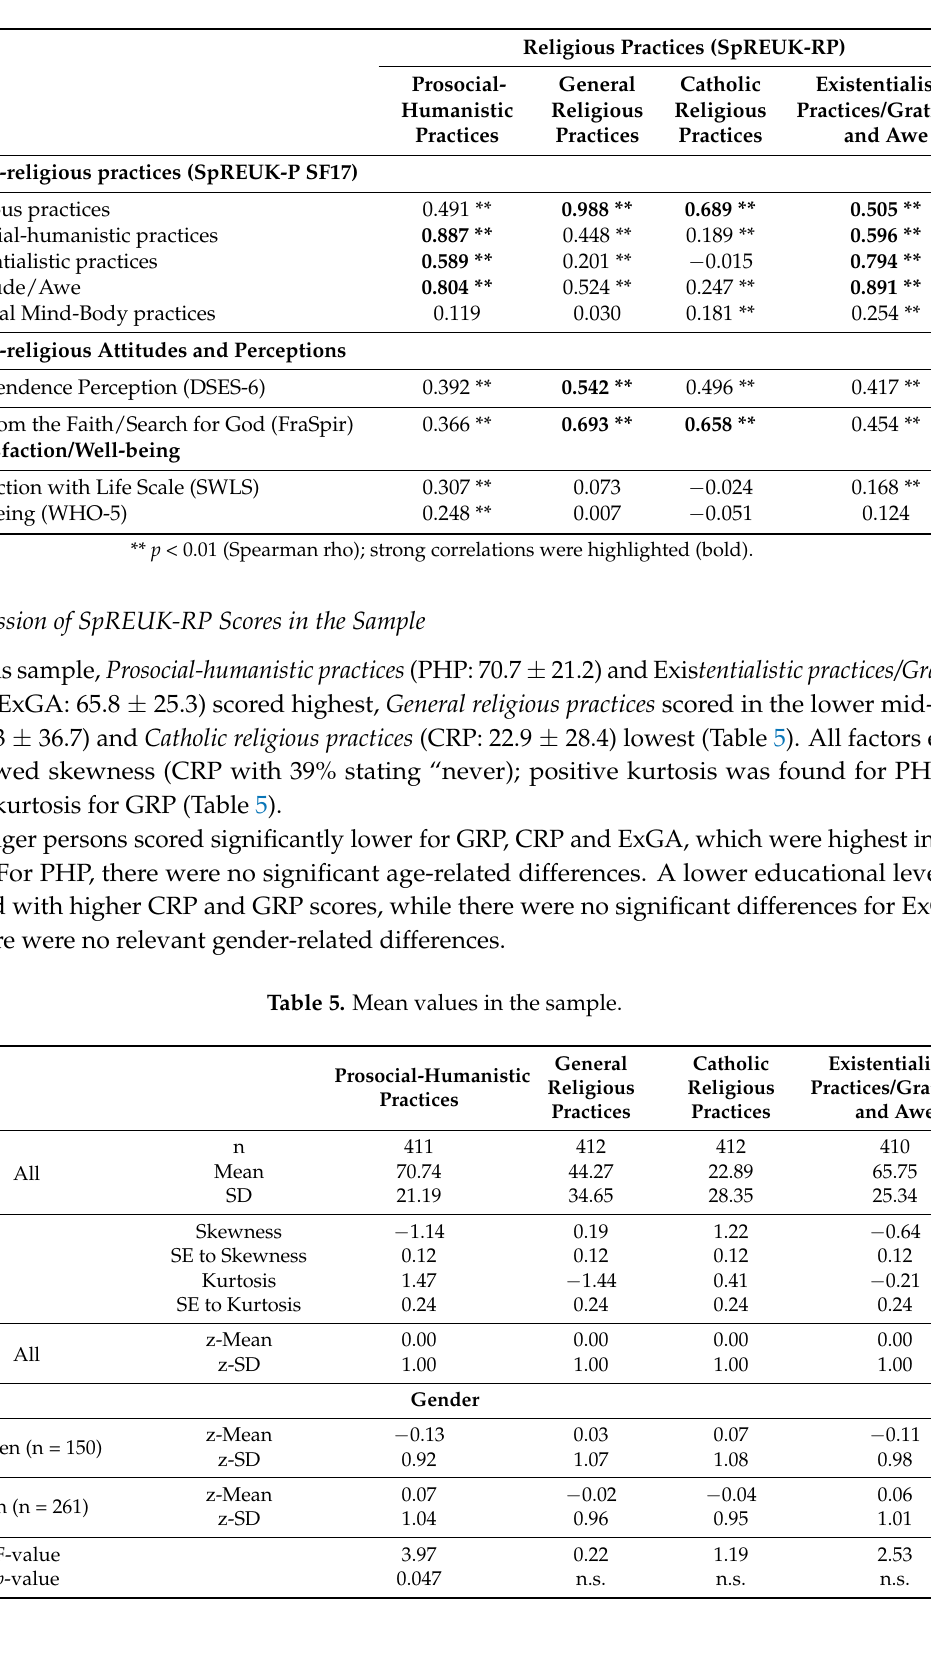
Table 4. Correlation analyses.